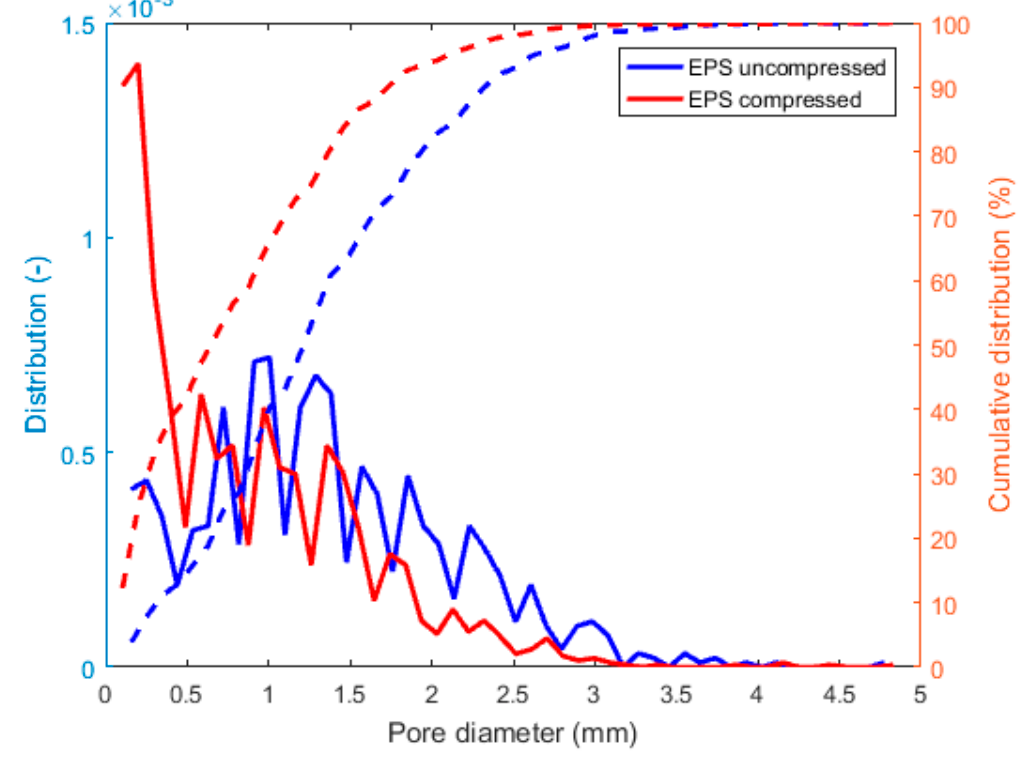
Figure 7. Pore size distribution and its cumulative distribution of the uncompressed and compressed specimens.